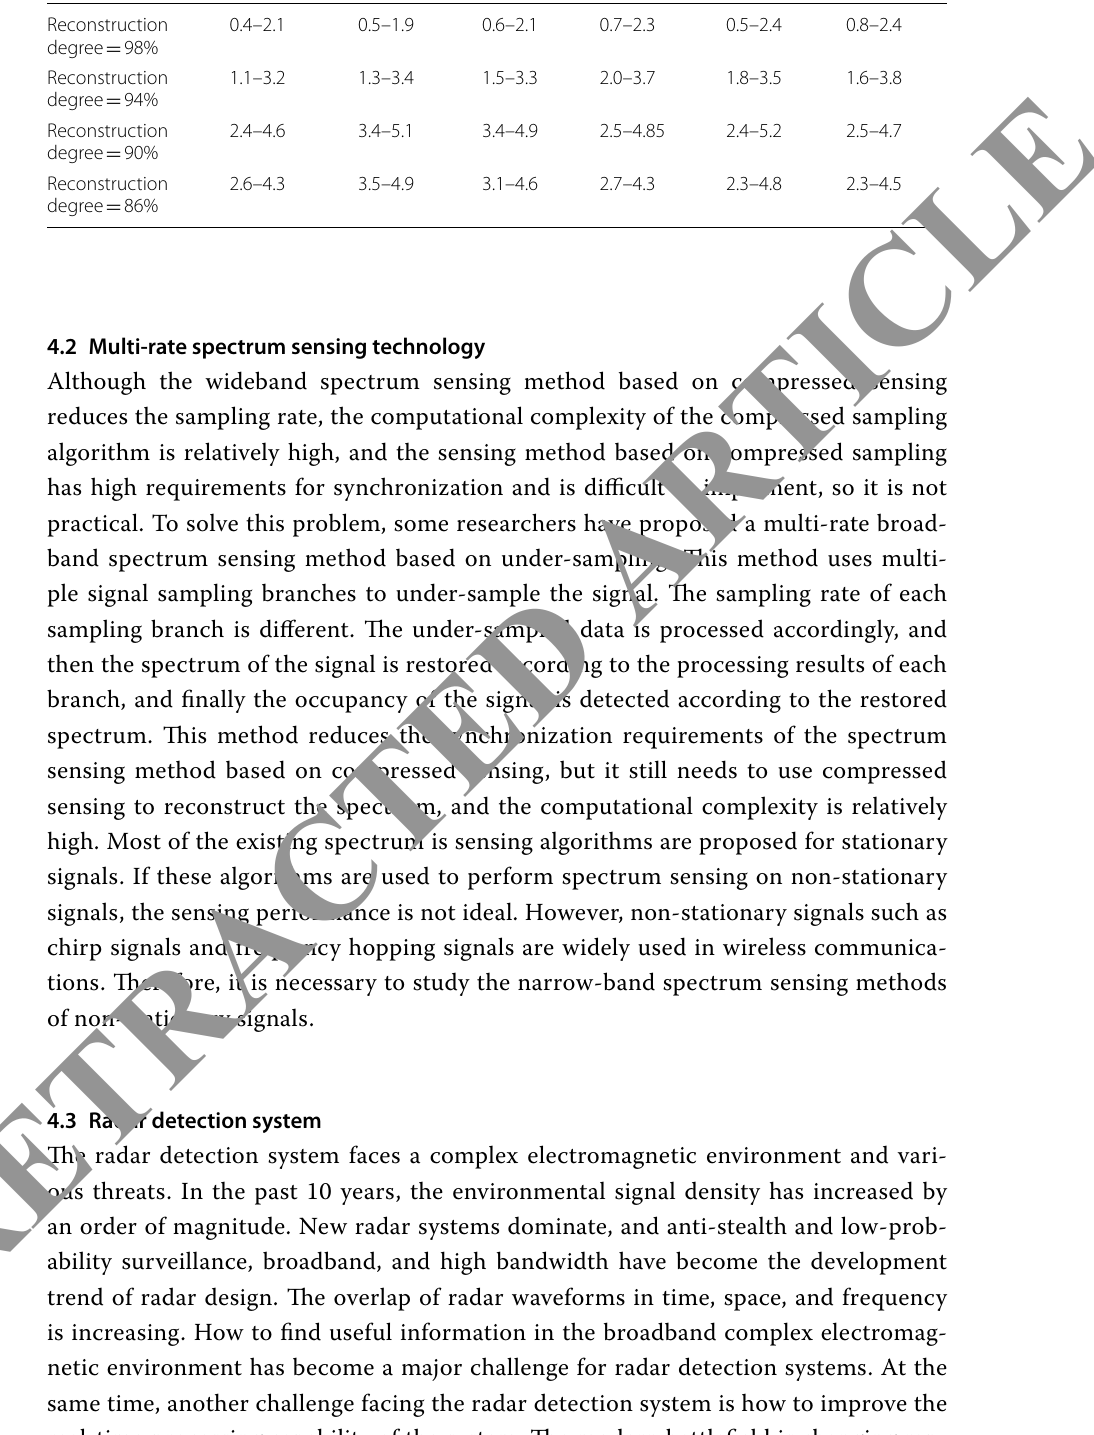
Table 9 The signal-to-noise ratio of the mixed signal is improved after PCA noise reduction